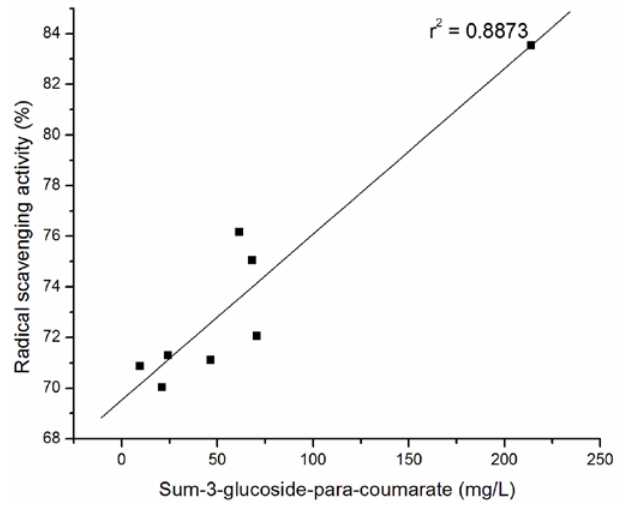
Figure 5 . Relationship between radical scavenging activity and sum of glucoside- p - coumarates of selected Cabernet Sauvignon wine